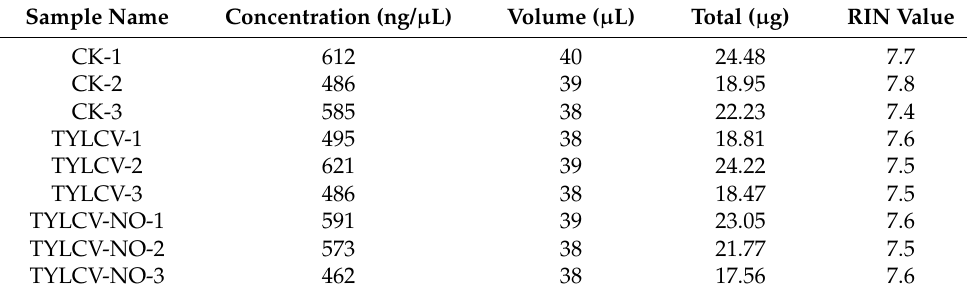
Table 3. Results of RNA sample quality